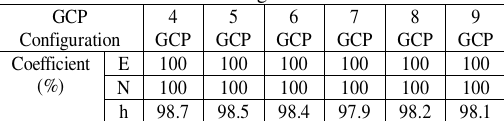
Table 1. Result on Coefficient Percentage based on Different GCP Configurations.